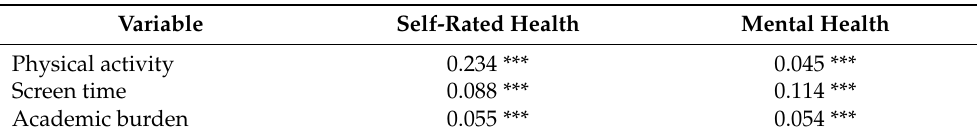
Table 4. The results of cluster analysis of physical activity, screen time, academic burden, and adolescent health. Variable Self-Rated Health Mental Health Physical activity 0.234 *** 0.045 *** Screen time 0.088 *** 0.114 *** Academic burden 0.055 *** 0.054